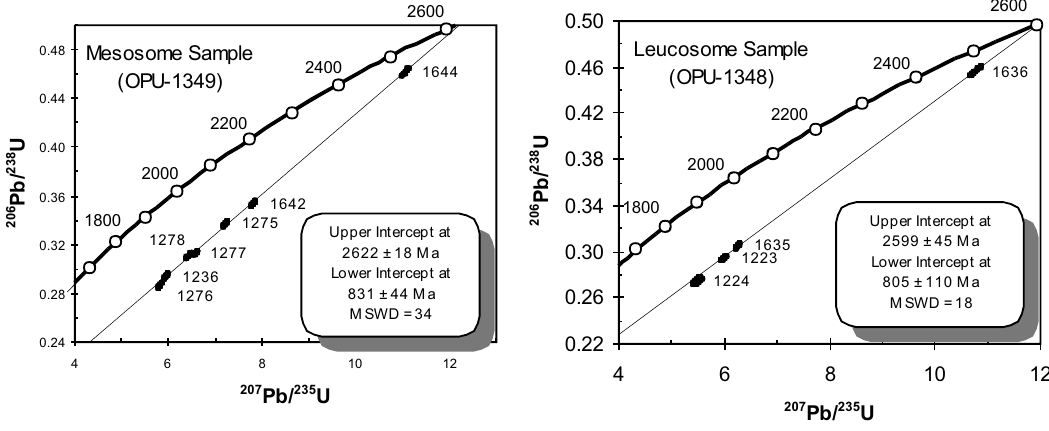
Fig. 6 – U-Pb Concordia diagrams for mesosome zircons (OPU 1349) and leucosome zircons (OPU 1348).